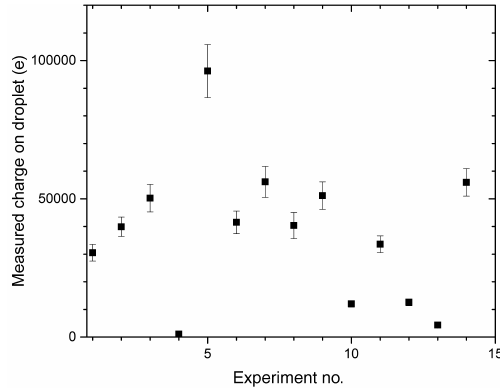
Figure 2. Measured elementary charge on droplets at different times. Error bars represent uncertainties in charge measurement due to the uncertainty in the measurement of the vertical distance trav- eled by the droplet. The mean charge averaged over all the experi- ments is 39000e with a standard deviation of